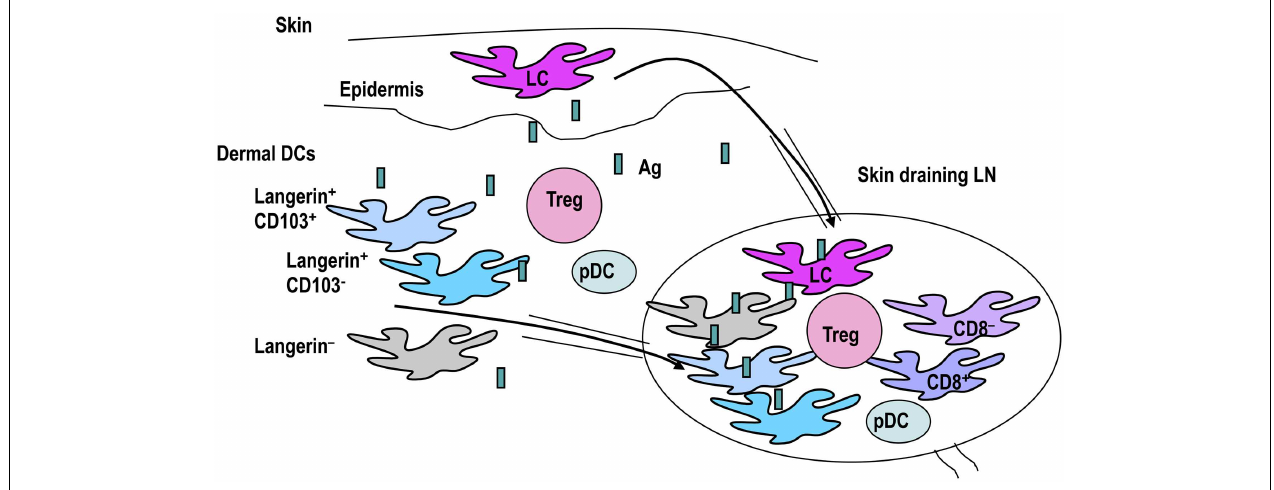
draining lymph nodes. Skin-draining lymph nodes contain many DC subsets, including skin migratory DCs, resident classical CD8 + DCs, CD8 − DCs, and pDCs.Therefore, interactions between DC subsets andT-regs in skin and skin-draining lymph nodes may be